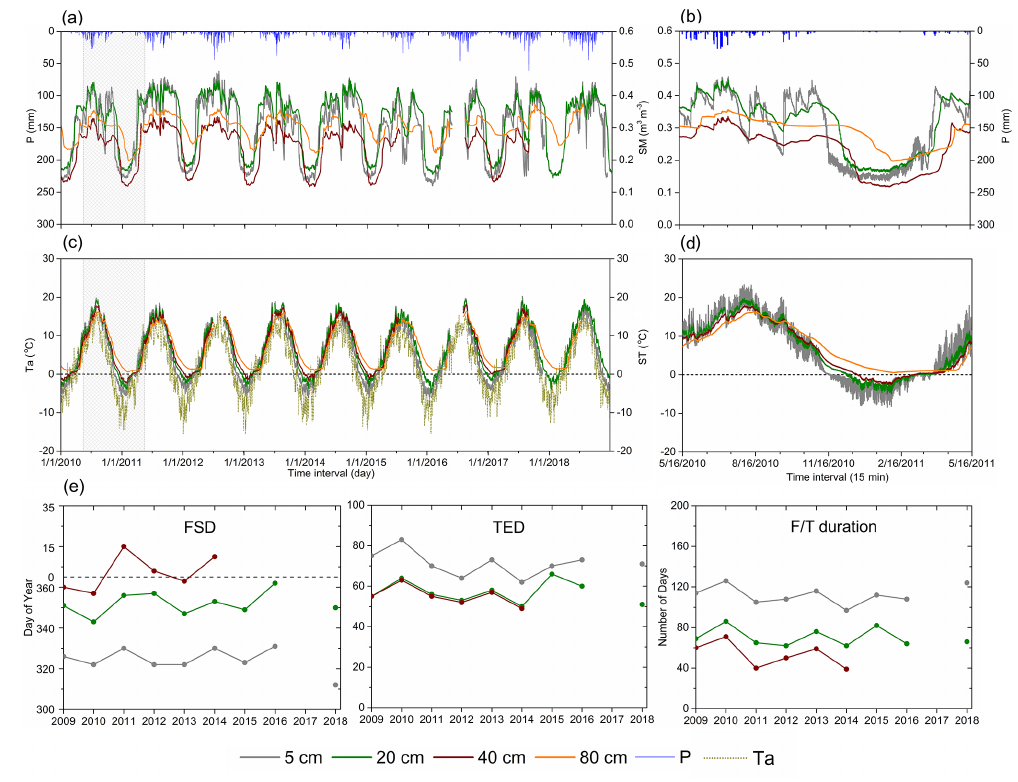
Figure 5. Time series of upscaled daily (a) SM ups and (c) ST ups at depths of 5, 20, 40, and 80cm for the Maqu network between Jan- uary 2010 and December 2018. The subplots highlight the time series of upscaled (b) SM ups and (d) ST ups with intervals of 15min between 16 May 2010 and 16 May 2011. (e) Annual variations in FSD, TED, and F/T duration at 5, 20, and 40cm depths. The time series of daily precipitation and air temperature are shown in panels (a) and (c) as